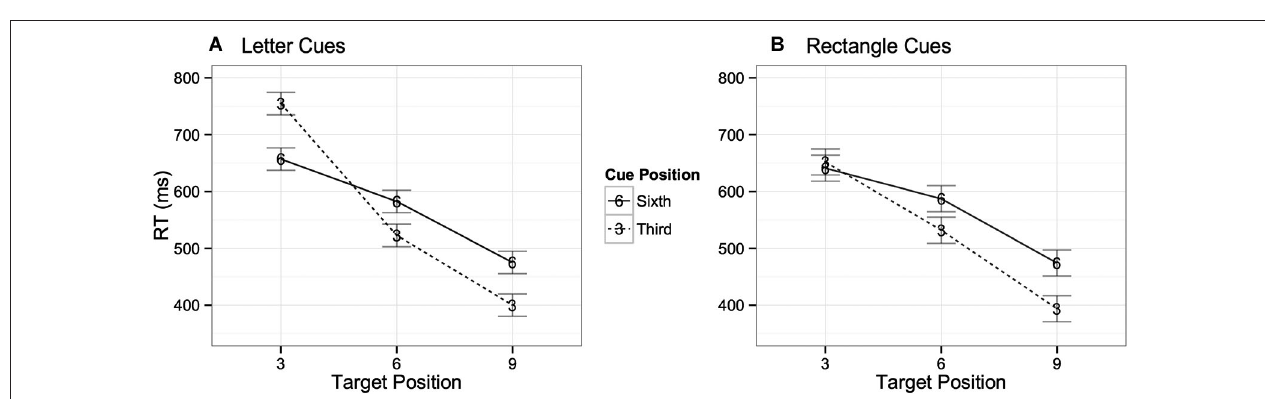
FIGURE 11 | Interaction between target position, cue position in temporal stream, and cue type. Graph (A) shows trials with letter cues, whereas Graph (B) shows those with rectangle cues.